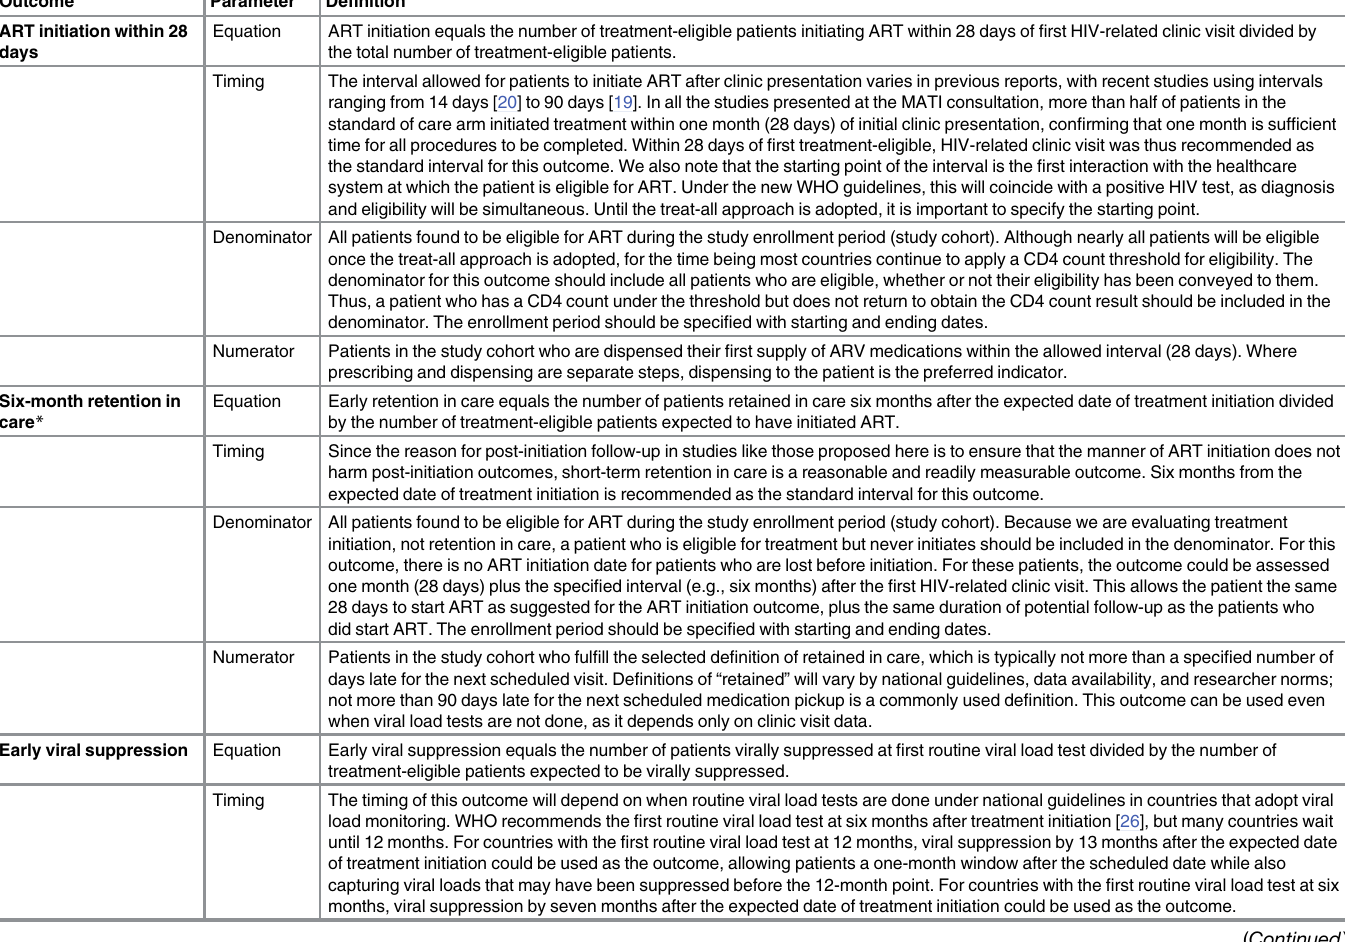
Table 1. Proposed primary outcomes for evaluation of ART initiation in general adult